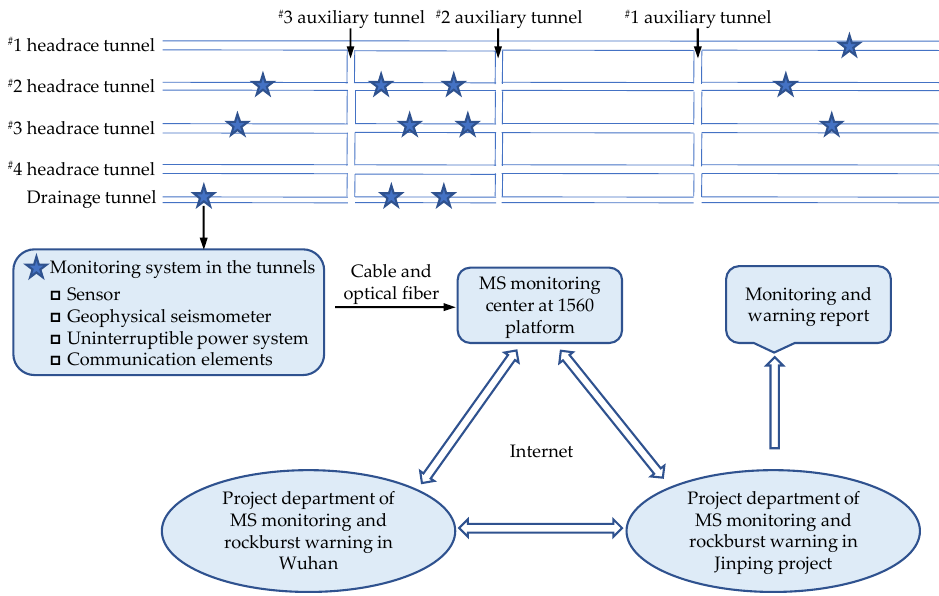
Figure 4. Communication network created to monitor rockbursts occurring in the tunnels of the Jinping II hydropower station in China.